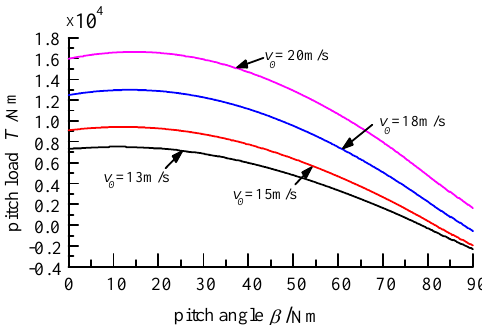
Figure 2. Curve of the relationship between pitch angle and pitch load.